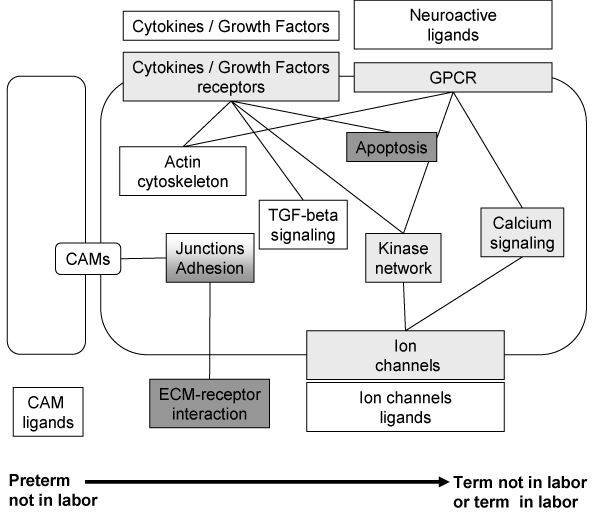
Main pathways represented in the myometrium on the basis of the genes detected in genomic studies. Gene transcripts pertaining to these pathways were either up-regulated (dark grey) or down-regulated (light grey) by a two fold or more factor. White boxes denote insufficiently documented links in context. Comparison between Preterm not in labor and Term not in labor or Term in labor. Pathways are shown with their known links to cytokine, growth factors (GF) and G-protein coupled membrane receptors (GPCR). CAMs, cell adhesion molecules. ECM, extra-cellular matrix).